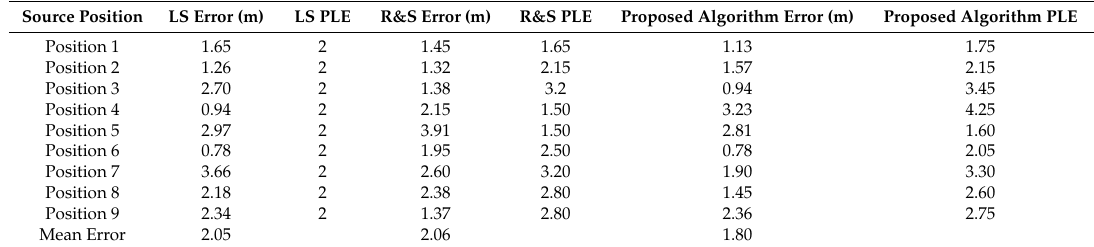
Table 6. Error comparison for seven measurement